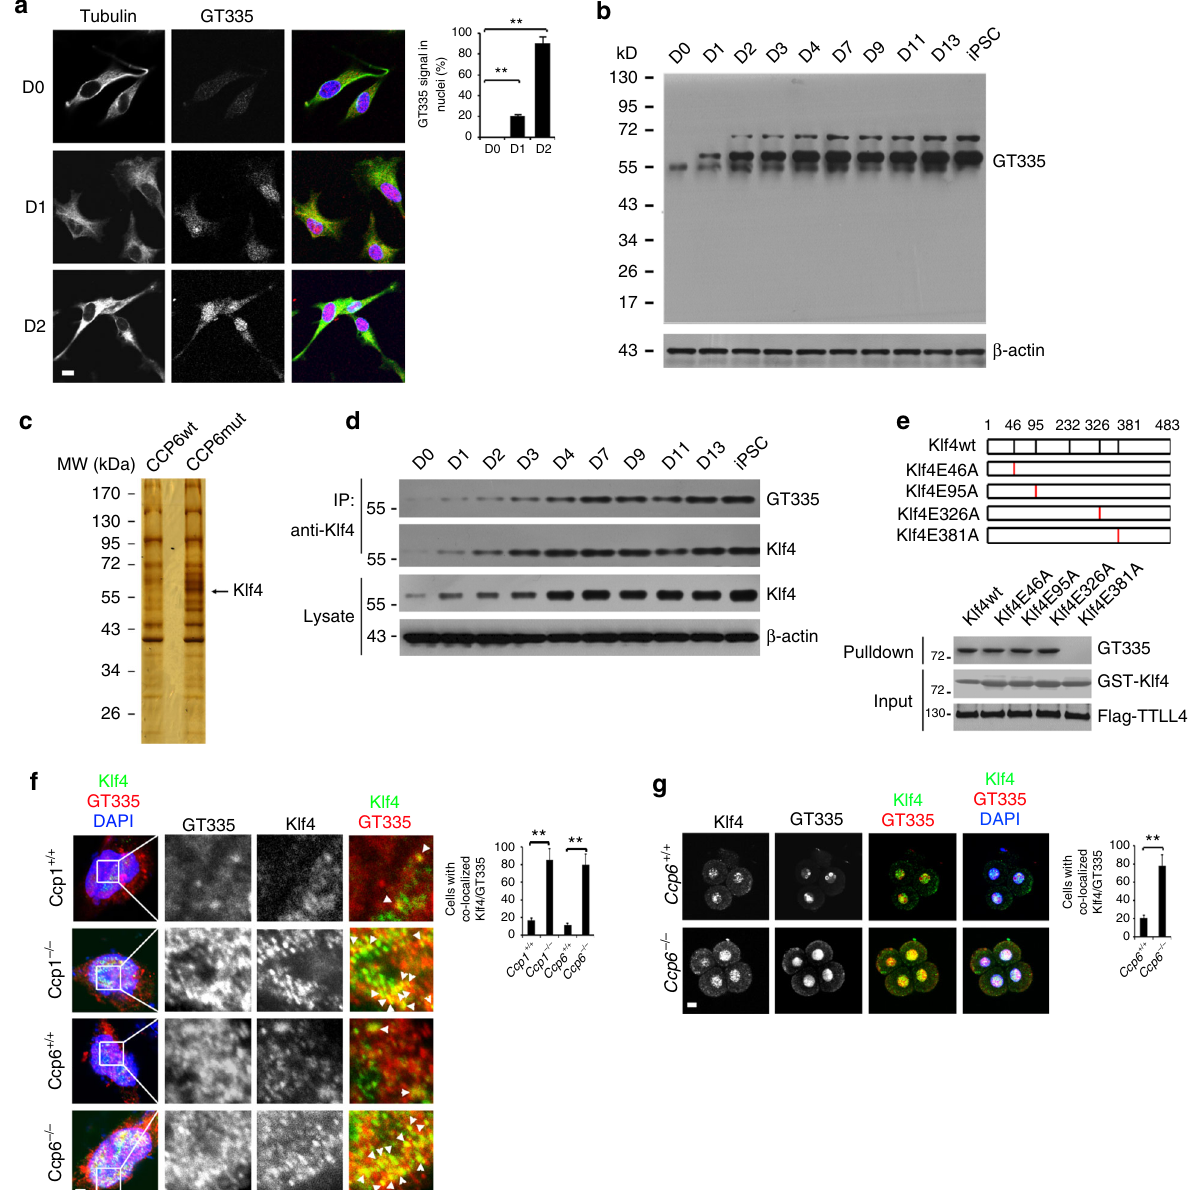
Fig. 3 Klf4 undergoes polyglutamylation in cell reprogramming and early embryogenesis. a MEFs were transduced with STEMCCA lentivirus for the indicated days and immunostained with anti-tubulin and GT335 antibodies. Nuclei were counterstained by DAPI. Scale bar, 10 μ m. Percentages of cells with GT335 signal localized in nuclei were counted as means ± S.D. ** P < 0.01. More than 100 typical cells were observed and calculated. n = 134 for D0, n = 122 for D1, n = 151 for D2. b MEFs lysates induced by OSKM for the indicated days were analyzed by immunoblotting with GT335 antibody. c Recombinant CCP6-wt and inactive CCP6 mutant (CCP6-mut) were immobilized to Af fi -gel10 resin. Lysates of OSKM-induced MEFs were added for af fi nity chromatography. The eluted fractions were visualized by SDS-PAGE followed by silver staining. The differential band around 60 kD appeared in CCP6-mut gel was cut for mass spectrometry and identi fi ed as Klf4. d MEFs Lysates induced by OSKM for the indicated days were immunoprecipitated with anti-Klf4 antibody and analyzed by immunoblotting with GT335. e Schematic representation of four putative glutamate-rich regions in Klf4 (left panel). GST-Klf4wt and indicated mutant proteins were incubated with Flag-TTLL4. GST-Klf4 proteins were pulled down by Glutathione Sepharose 4B beads, followed by immunoblotting. f CCP1 - and CCP6 -de fi cient MEFs were transduced with OSKM and stained with anti-Klf4 antibody. Nuclei were stained by DAPI. Scale bar, 10 μ m. Percentages of cells with Klf4/GT335 colocalization in nuclei were counted as means ± S.D. ** P < 0.01. 102 Ccp1 +/+ MEF cells, 112 Ccp1 − / − MEF cells, 104 Ccp6 +/+ MEF cells and 117 Ccp6 − / − MEF cells were observed. n = 4. g CCP6 -de fi cient embryos were isolated and immunostained with anti-Klf4 and GT335 antibodies. Percentages of cells with Klf4/GT335 colocalization in nuclei were counted as means ± S.D. ** P < 0.01.110 Ccp6 +/+ embryos and 116 Ccp6 − / − embryos were observed. Scale bar, 20 μ m. Student ’ s t test was used as statistical analysis. The data represent four independent experiments. MW molecular weight